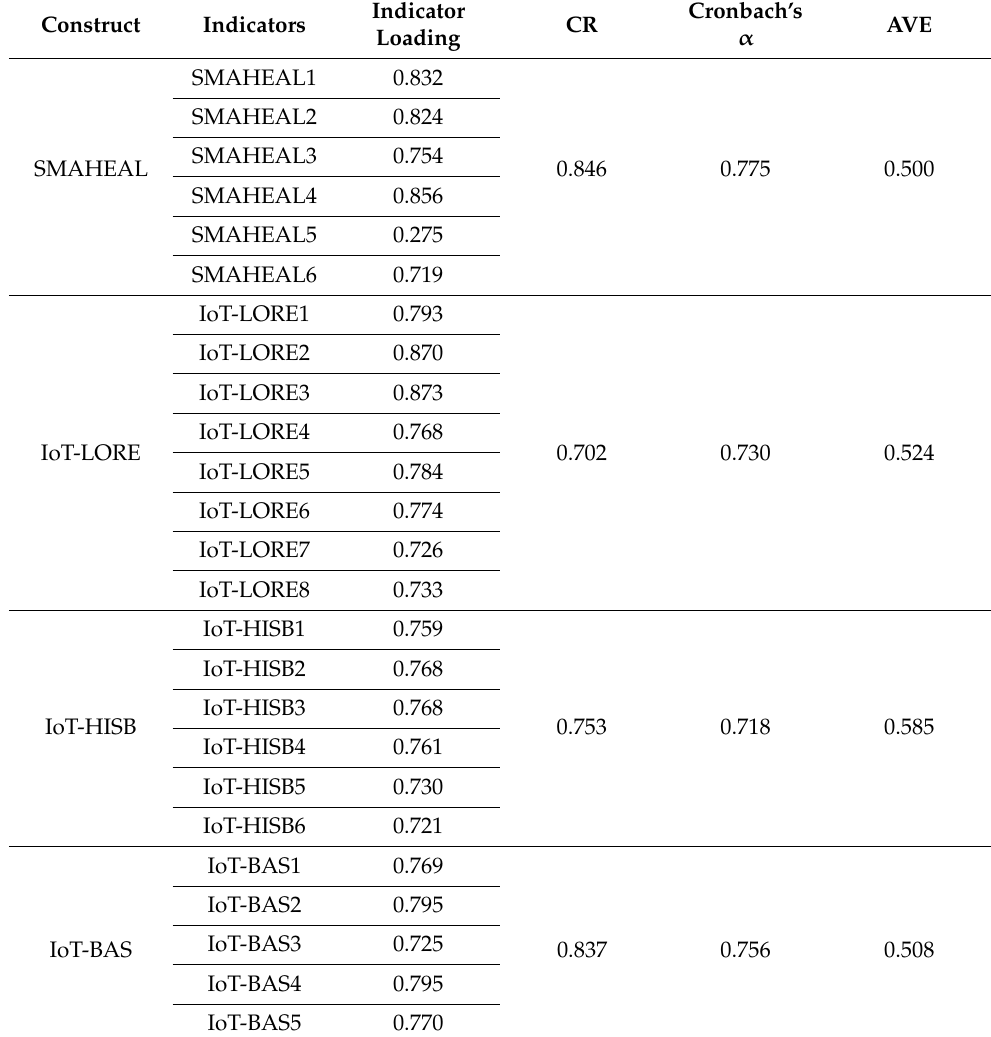
Table 3. Assessment of the study measurement.